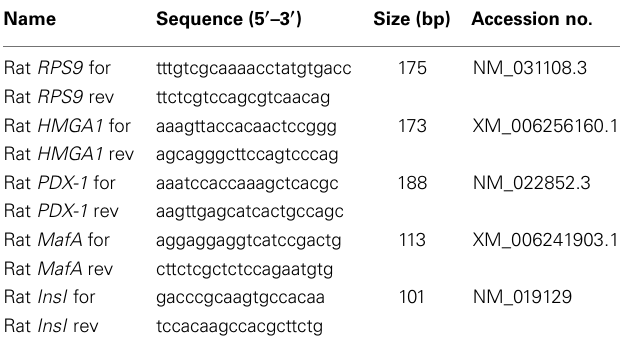
Table 2 | Gene-specific primers for Real-Time PCR